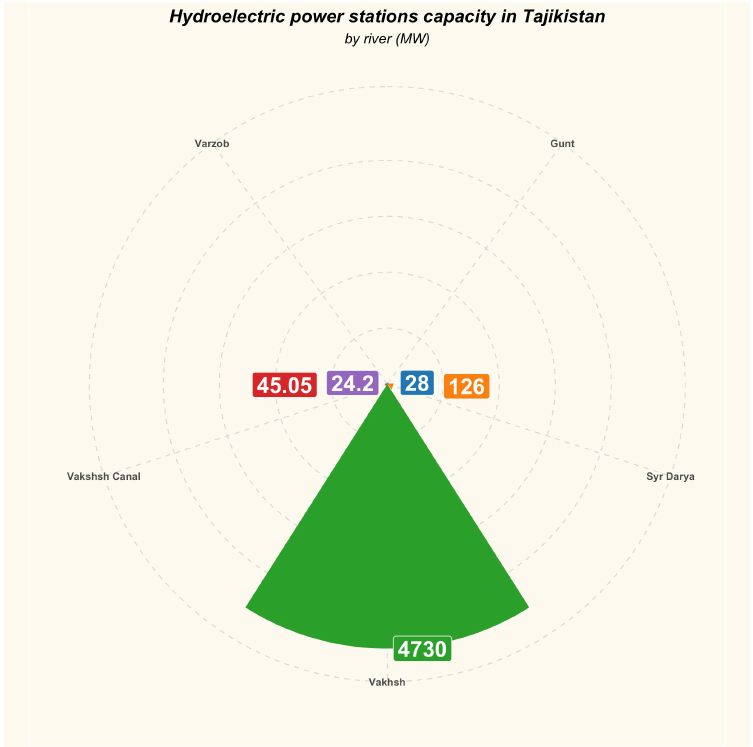
Figure 7. Hydroelectric power station capacities in Tajikistan by river. Data source: Tajikistan Energy Ministry: Jelektrojenergeticheskaja